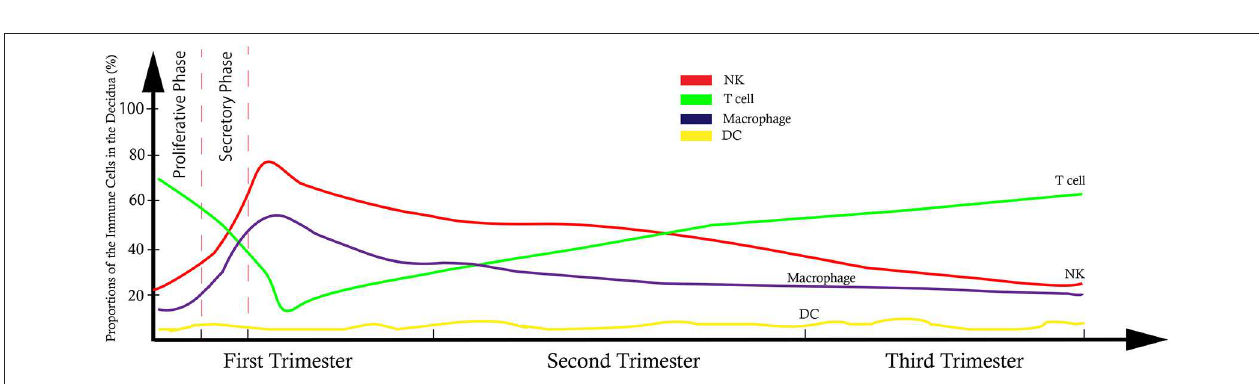
menstrual cycle. They showed an increase in NK cell numbers during the secretory phase by immunohistochemistry analysis (12). More studies suggest that the number of NK cells gradually